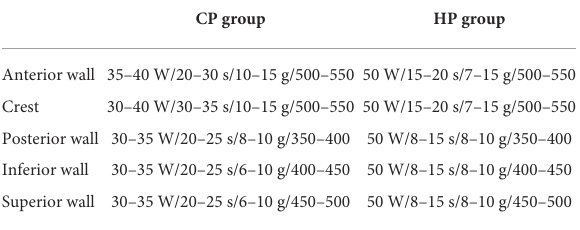
TABLE 1 Ablation